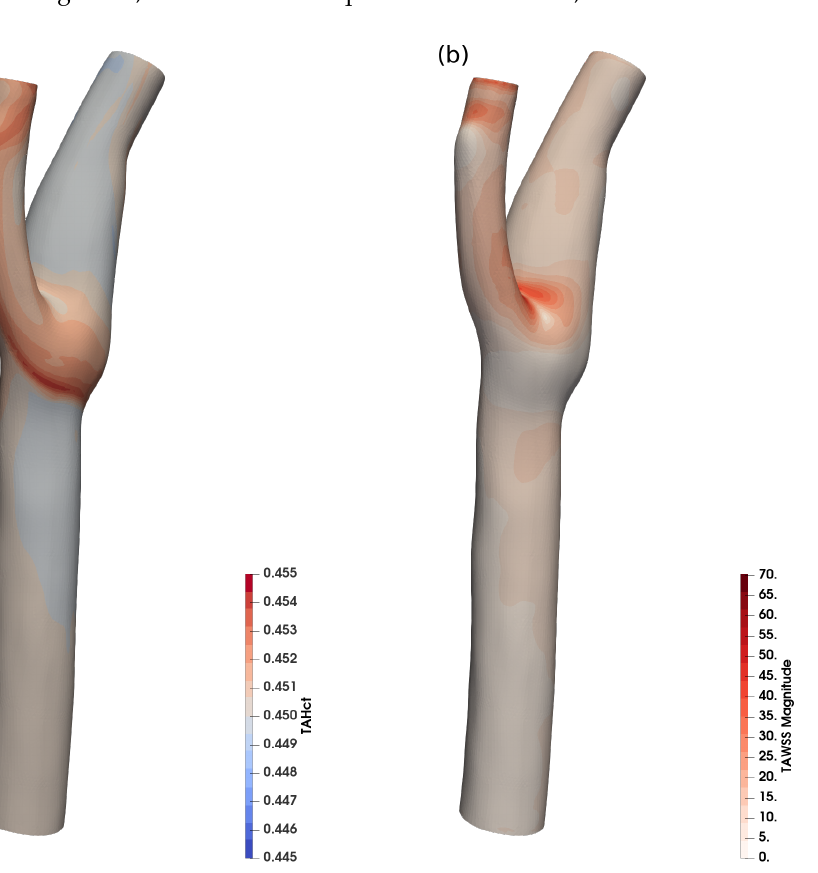
Figure 8. Time averaged haematocrit ( a ) and WSS ( b ) in a realistic human carotid, 900 k